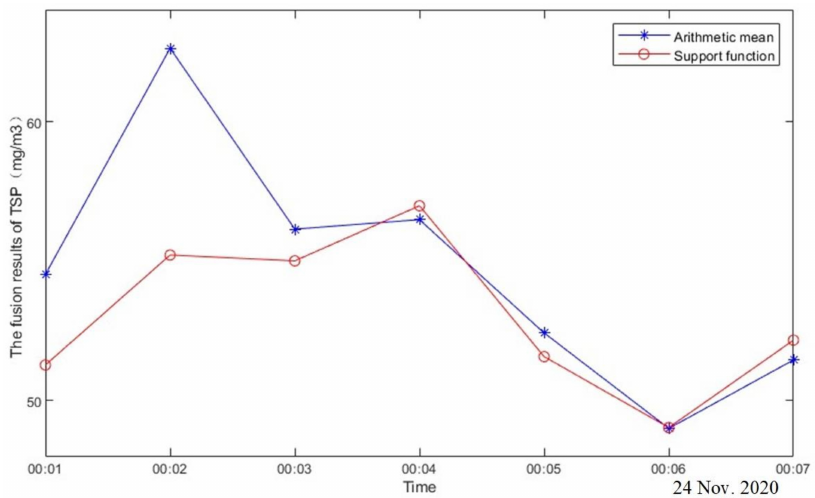
Figure 10. Data-fusion results obtained in two